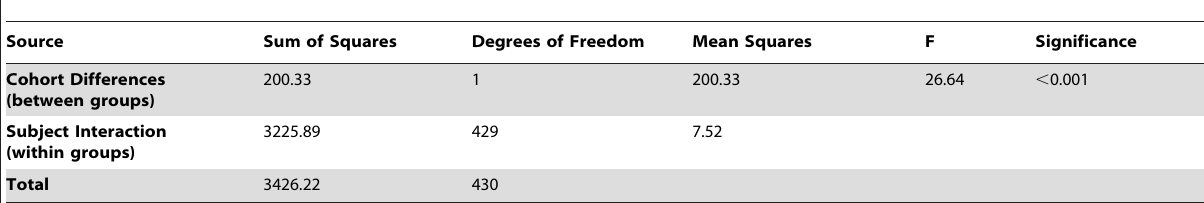
Table 5. Analysis of Variance for Cohort Main Effects.